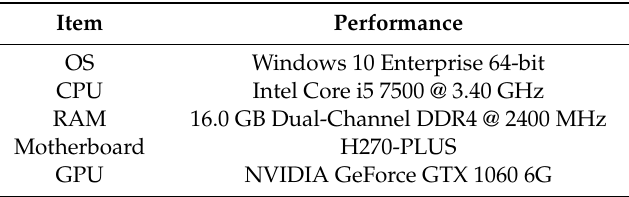
Table 3. Desktop PC (A) specifications.